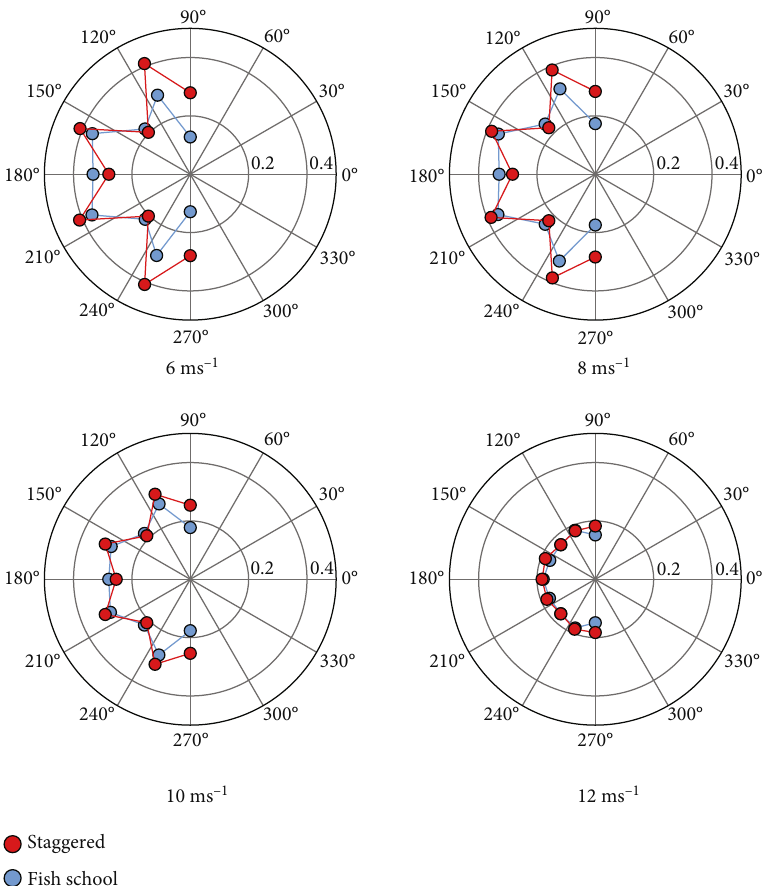
Figure 7: Average power coe ffi cient as a function of direction and wind